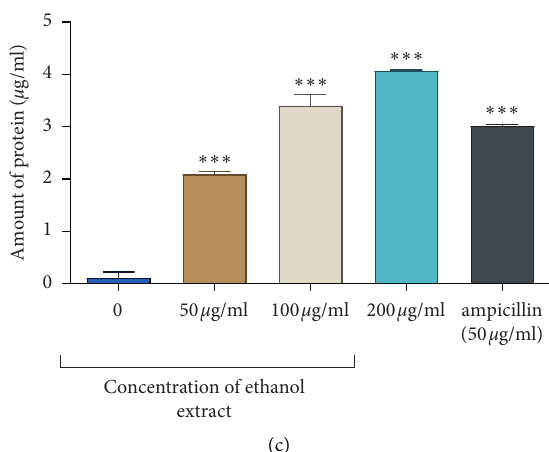
Figure 8: The effects of the ethanol crude on protein leakage in C. krusei, M. smegmatis, and P. aeruginosa . The results show the protein leakage assay for the effect of P. thonningii extract on C. krusei (a), M. smegmatis (b), and P. aeruginosa (c). The assay was carried out at varying concentrations of both the drug and extract. The positive control for C. krusei was miconazole, for M. smegmatis was 0.1% SDS, and for P. aeruginosa was ampicillin. ∗ P < 0 . 05, ∗∗ P < 0 . 001, and ∗∗∗ P < 0 .